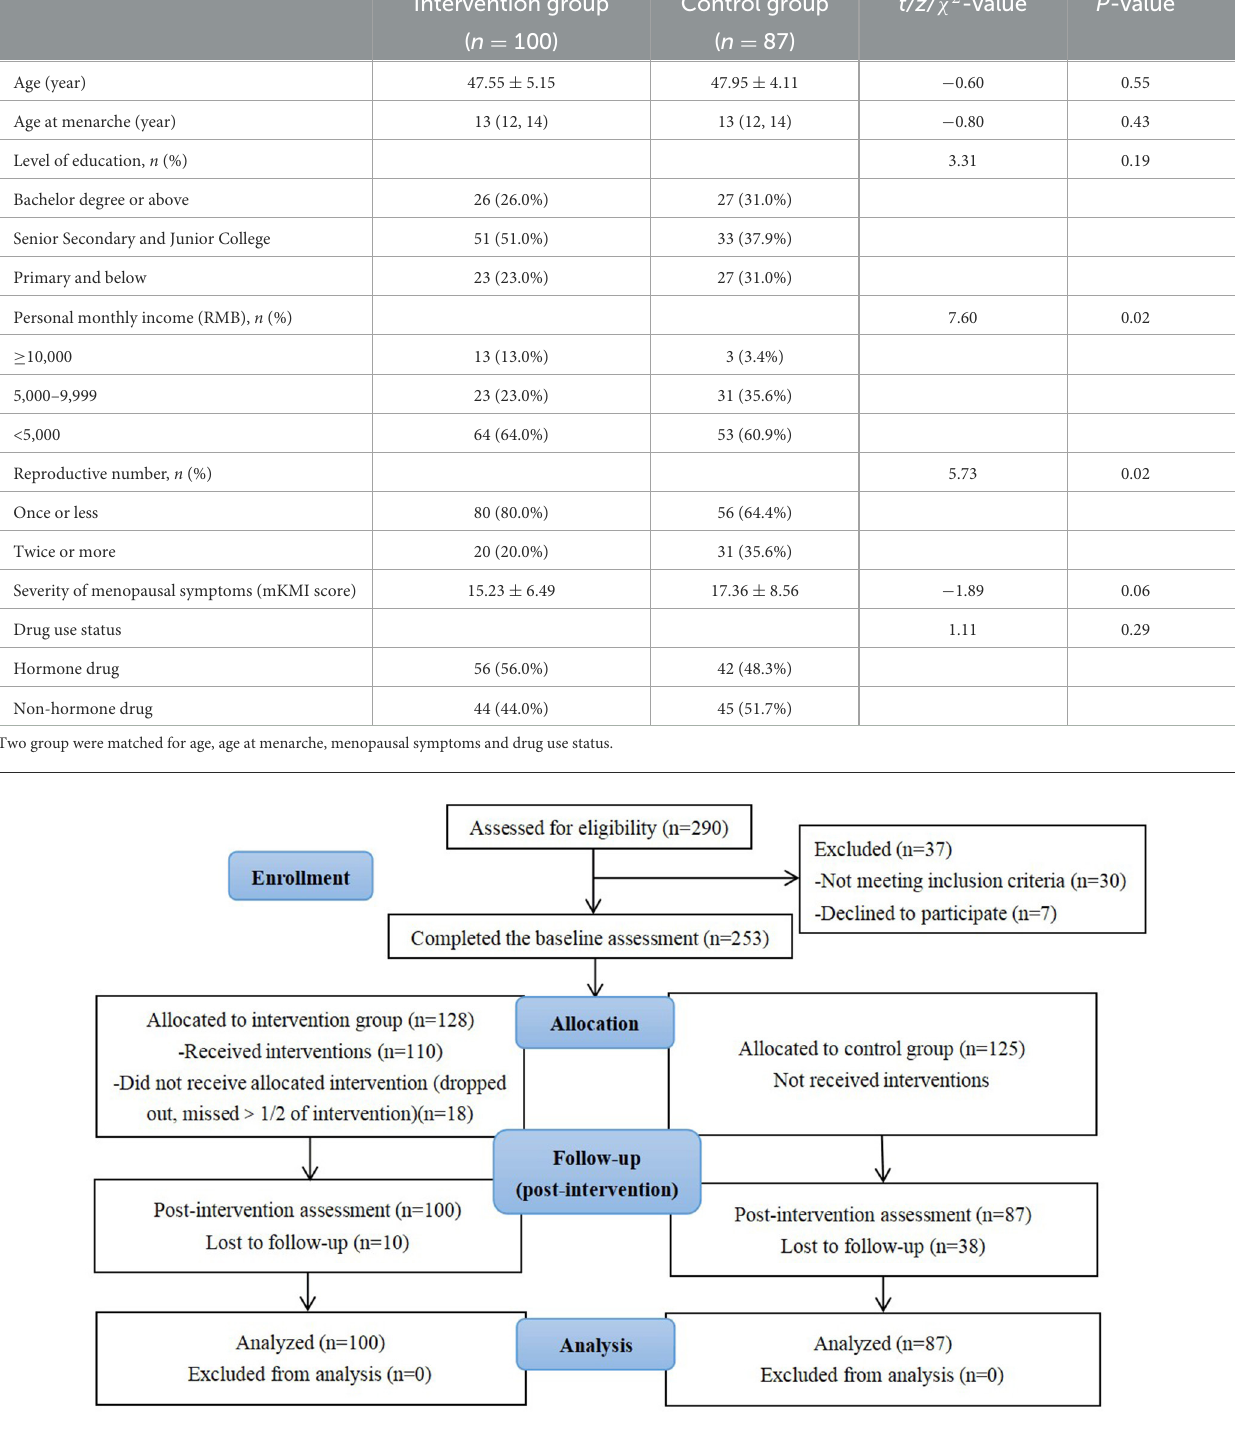
FIGURE1 CONSORT flow